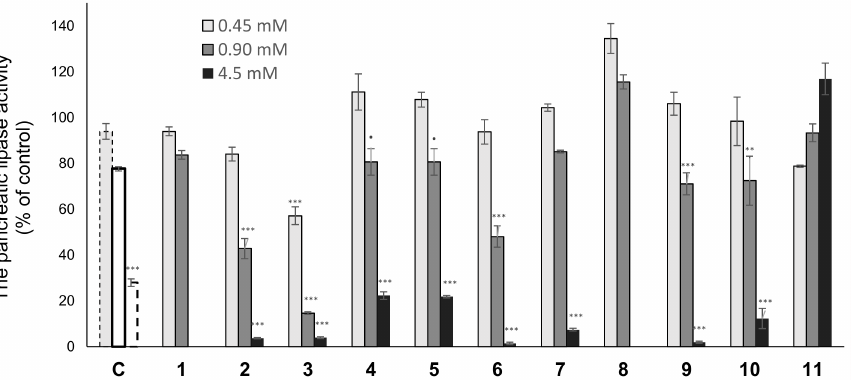
Figure 3. The pancreatic lipase activity of 1 – 11. Compounds 1 and 8 (0.45 and 0.90 mM), 2 – 7 and 9 – 11 (0.45, 0.90, and 4.5 mM), and cetilistat (c) (0.1 [ ], 1.0 [ ], and 10 [ ] µ M); Data are represented as the mean ± S.E.M. of three experiments performed in triplicate; *** p < 0.0001 vs. control, ** p < 0.001 vs. control, ˙ p < 0.05 vs.